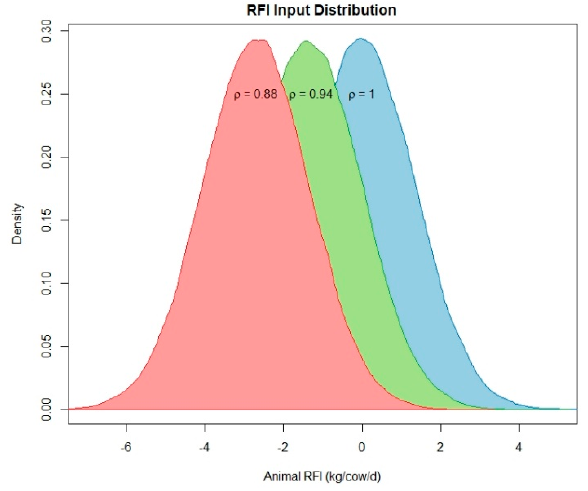
Figure 3. Graphical depiction of the distributions of the ρ parameters implemented to alter the residual feed intake (RFI) which we use as a phenotypic representation of individual animal feed efficiency. ρ represents the proportion of intake.